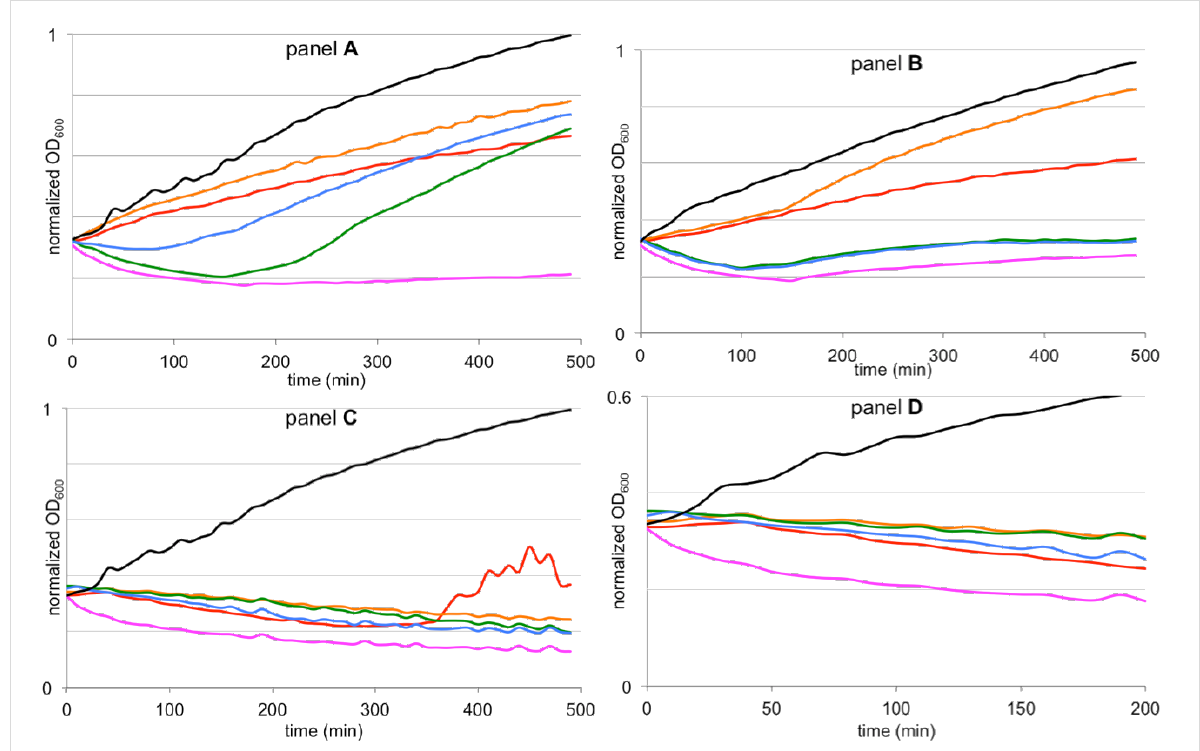
Figure 3: Growth kinetics of B. megaterium under the influence of different amounts of synAMP (red: (RW) 3 ; orange: (RW) 3 ; green: RcCO-W(RW) 2 ; blue: RcCO-W(RW) 2 ), nisin (magenta), and a control (black). With 2 × MIC (1.6 µg/mL for (RW) 3 and 3.8 µg/mL for RcCO-W(RW) 2 panel A ), 4 × MIC (3.2 µg/mL for (RW) 3 and 7.6 µg/mL for RcCO-W(RW) 2 ; panel B , note: The green line for RcCO-W(RW) 2 is under the blue line for RcCO-W(RW) 2 ), and 8 × MIC (6.4 µg/mL for (RW) 3 and 15.2 µg/mL for RcCO-W(RW) 2 ; panel C and D ). Gridlines at 0.2, 0.4, 0.6, and 0.8 normalized OD 600 are shown.